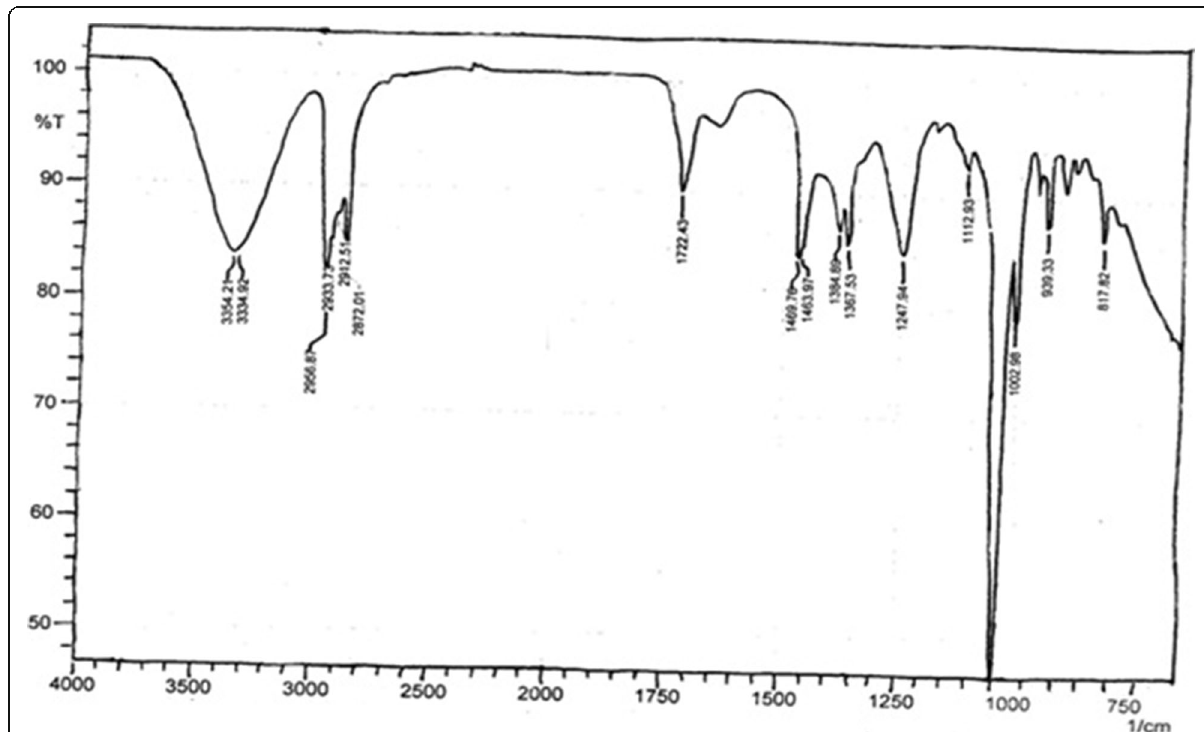
Fig. 8 FTIR spectrum of n -butanol fraction of B.orthobotrys